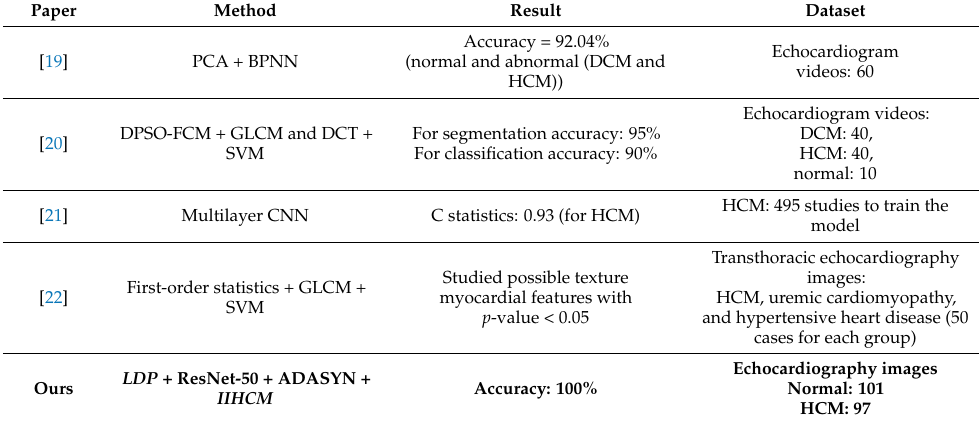
Table 6. Summary of state-of-the-art work using echocardiogram